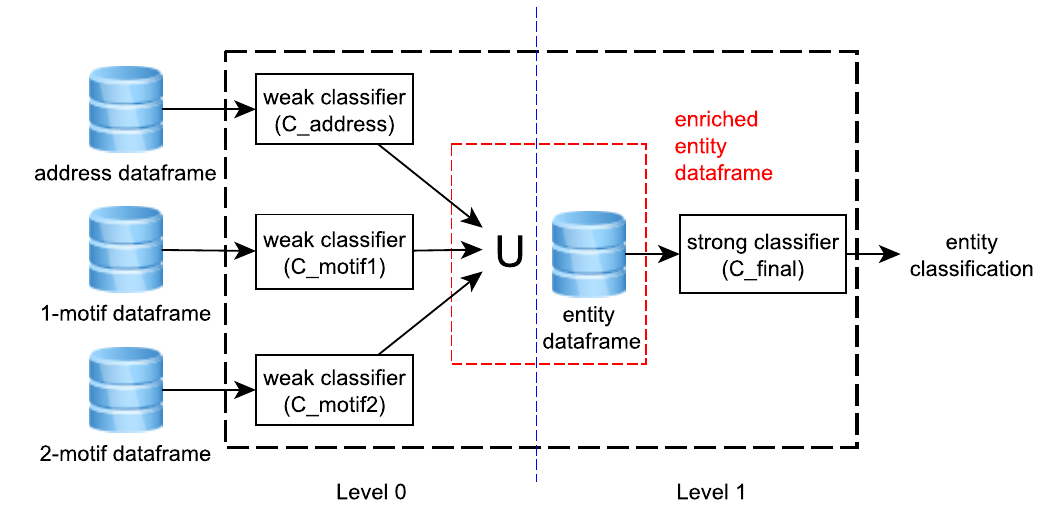
Figure 3. Cascading machine learning